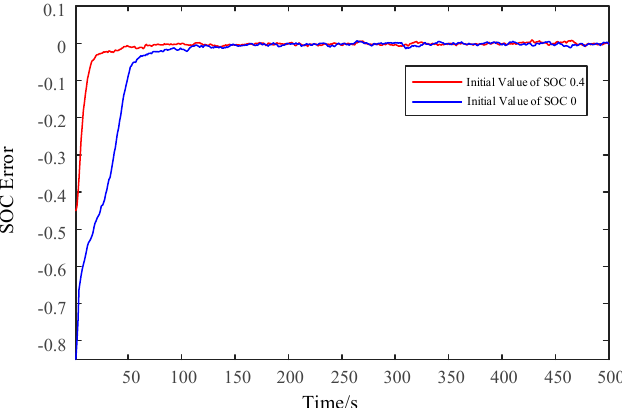
Figure 10. SOC estimation error curve based on F-UKF under discharge conditions with constant-current pulses.